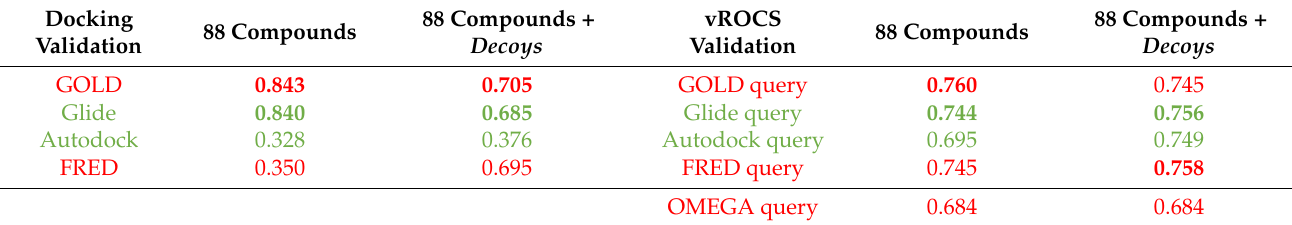
Table 2. AUC values obtained in corresponding ROC curves plotted for docking and shape similarity (vROCS) validations, where queries refer to poses of compound 1 obtained by the corresponding docking software and applied to the dataset of 88 compounds, with and without